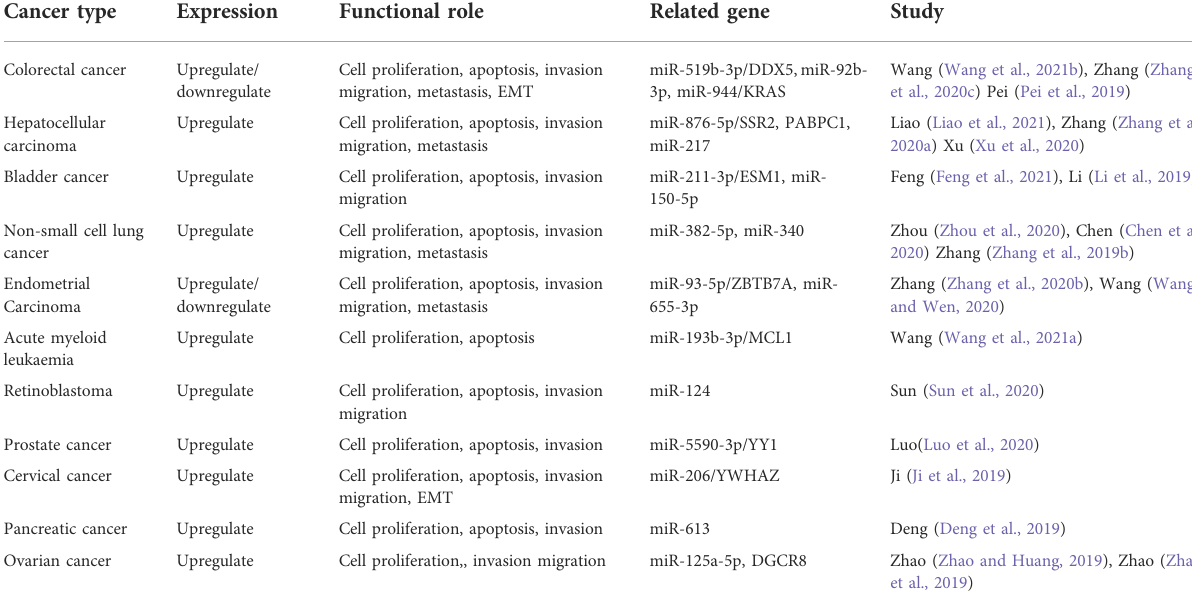
TABLE 5 Summary of lncRNA SNHG14 functional role and related